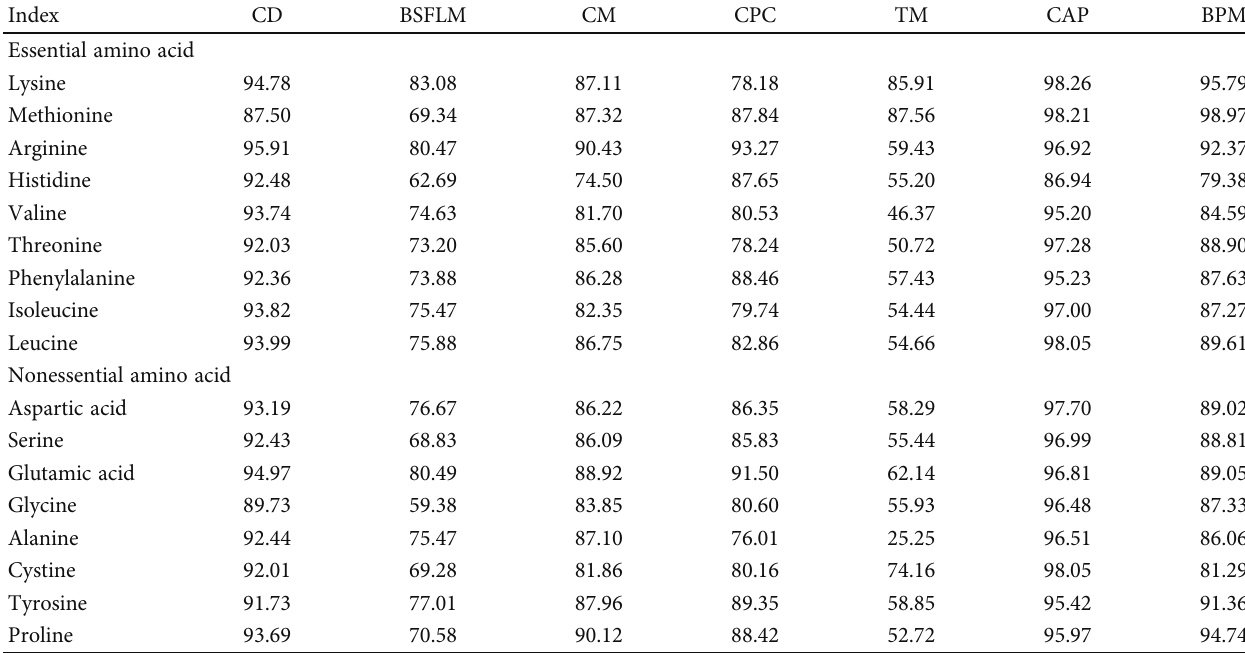
Table 6: Apparent digestibility coe ffi cients for amino acids of test ingredients in Litopenaeus vannamei